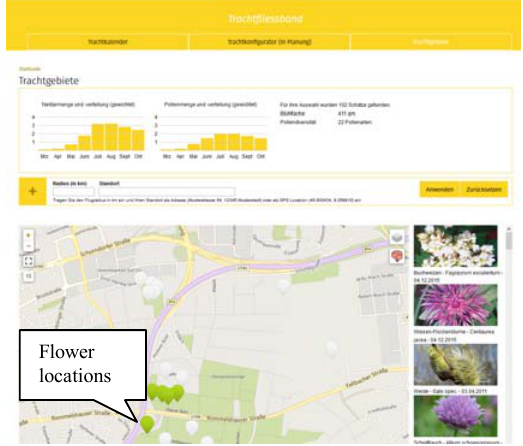
Figure 14: Automatic estimation of honey yield in a selected area with different flower locations (Source: Boris Willi).